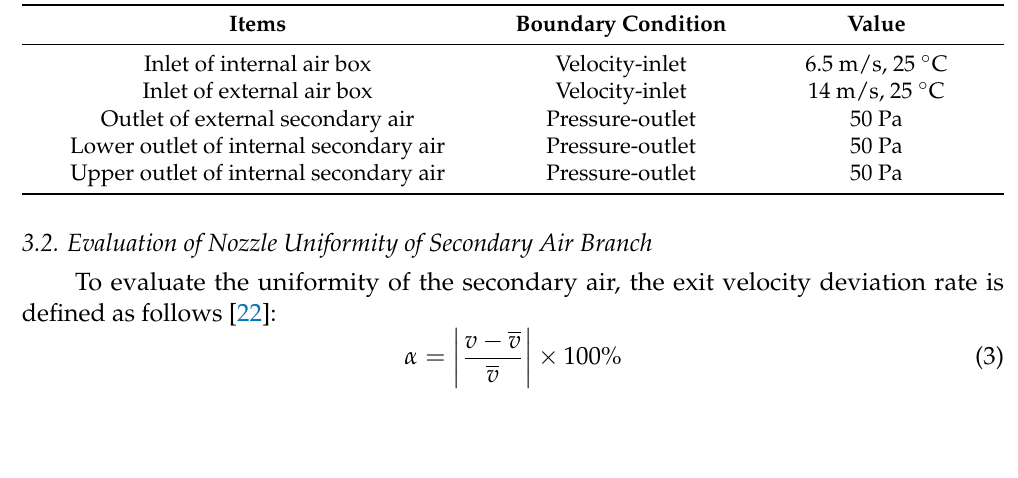
Figure 7. Grids of secondary air system and pipes. ( a ) Mesh generation of internal side upper and lower secondary air. ( b ) Mesh generation of secondary air calculation on the outside. Table 2. Calculation conditions of 660 MW ultra-supercritical CFB boiler.